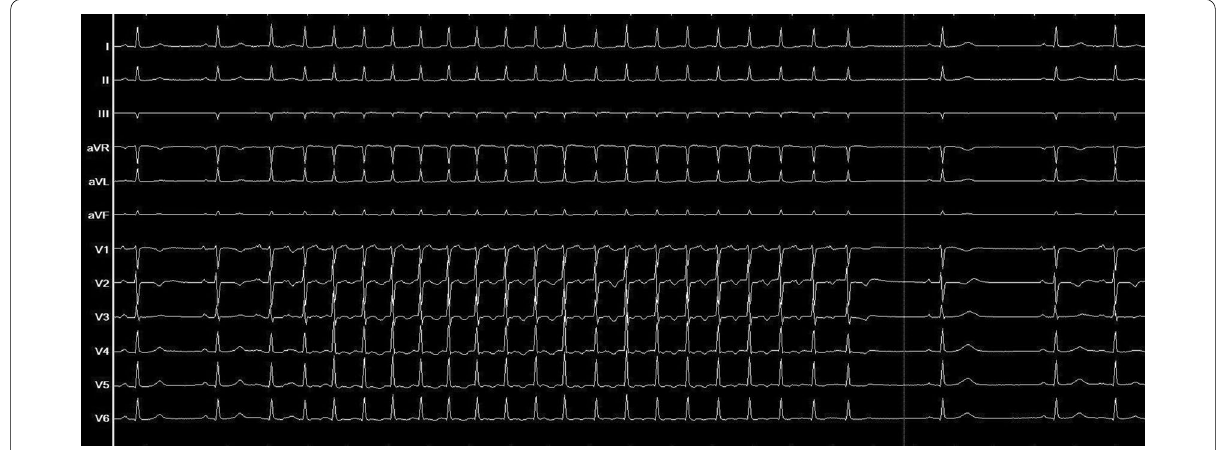
Fig. 1 A 12-lead Electrocardiogram demonstrating a narrow QRS complex tachycardia